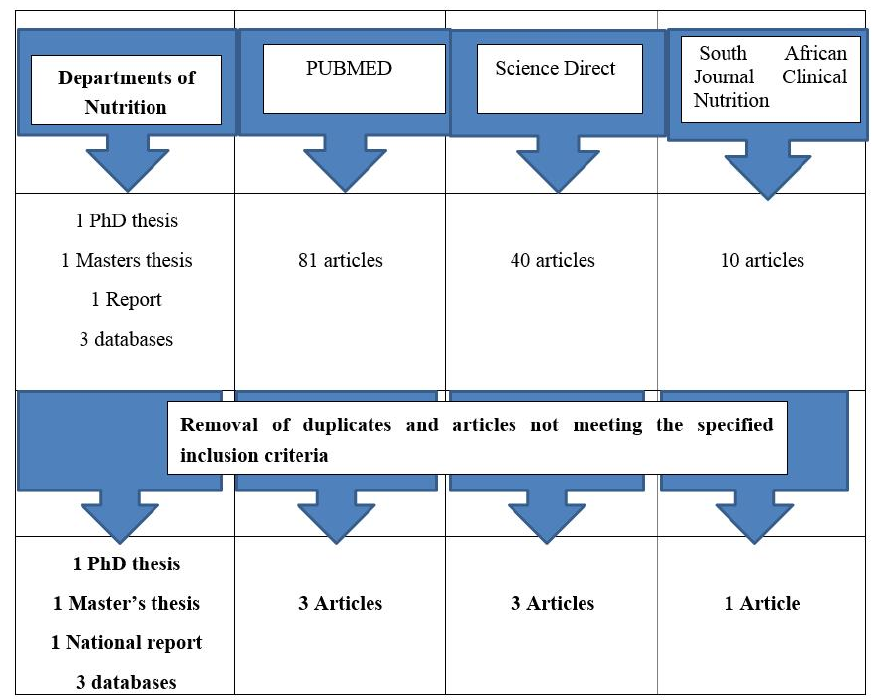
Figure 1. Schematic presentation of the literature search undertaken to find dietary surveys done in South Africa after